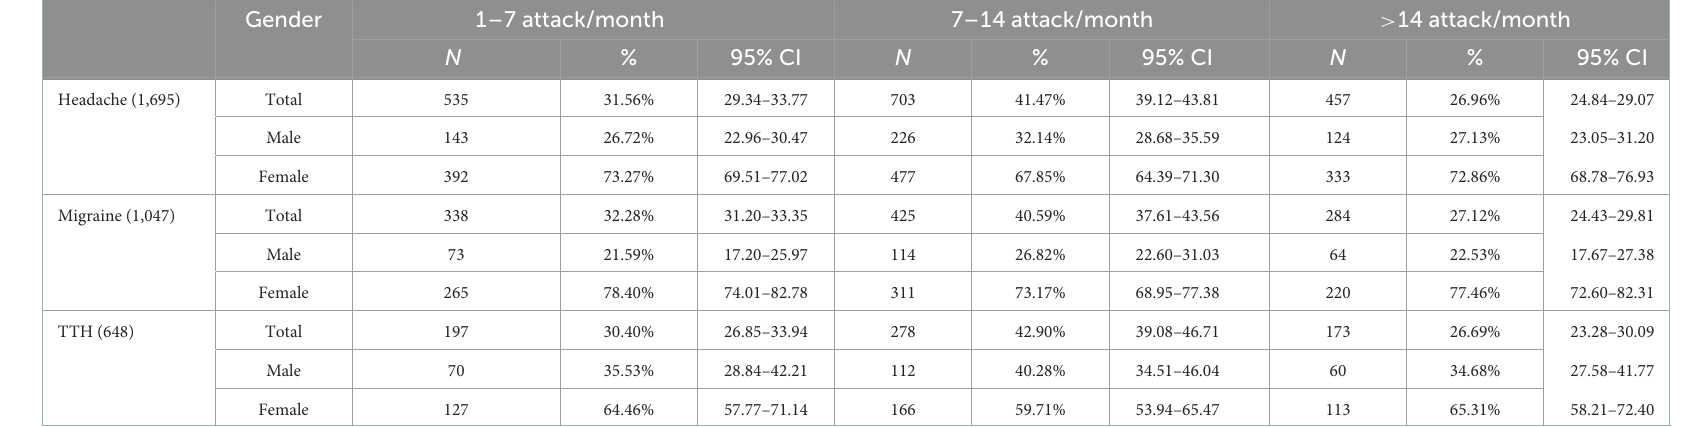
TABLE 5 One-year prevalence of headache and its type on the number of attacks per month by gender.